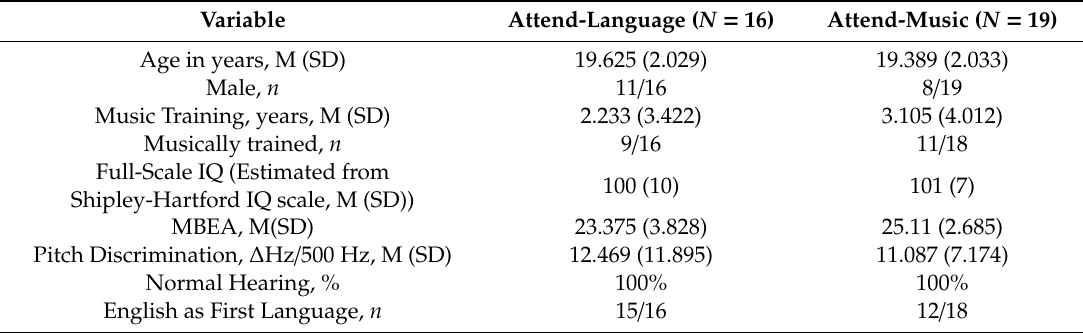
Table 1. Demographics and baseline test performance of the participants. Data are shown as mean (SD), range, or proportion. SD: Standard Deviation. n : Count in proportion.